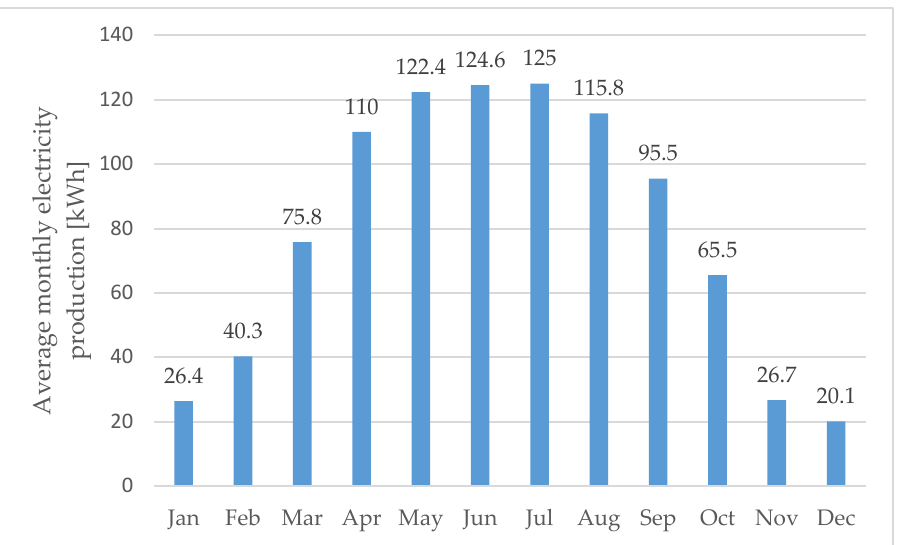
Figure 6. Annual electricity production from 1 kWp of PV system.